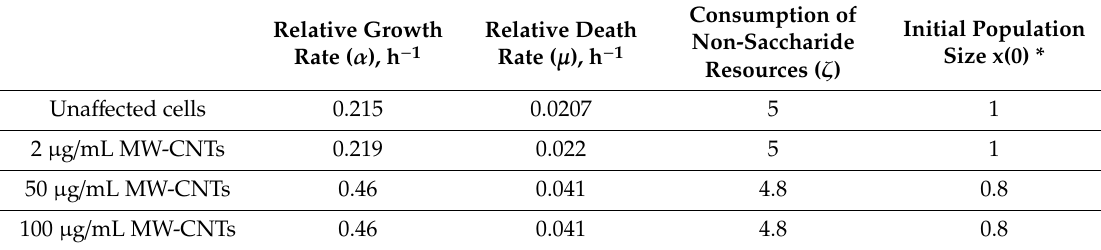
Figure 6. Dependence of optical density on time at different MW-CNTs concentration: ( a ) without Table 1. Parameters of the model.